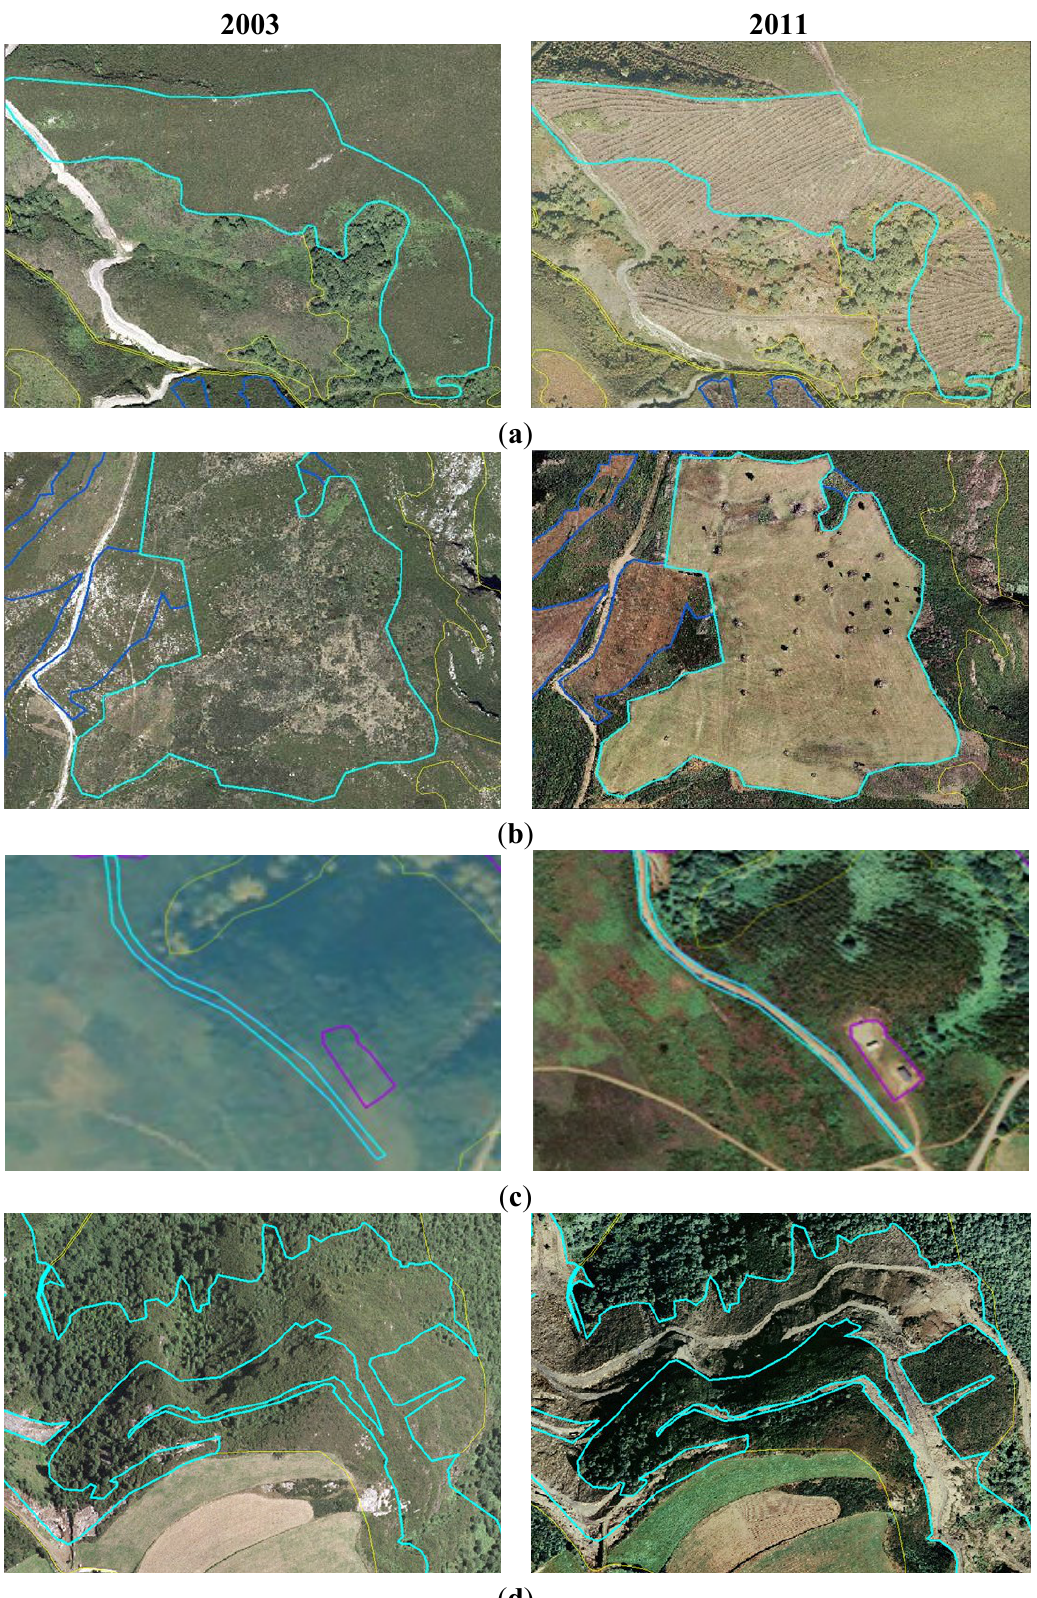
Figure 4. Examples of destruction of the habitat type European dry heaths (Nat-2000 4030) in the study area during the period 2003–2011. ( a ) afforestations; ( b ) pasturelands; ( c ) infrastructures and buildings; ( d )